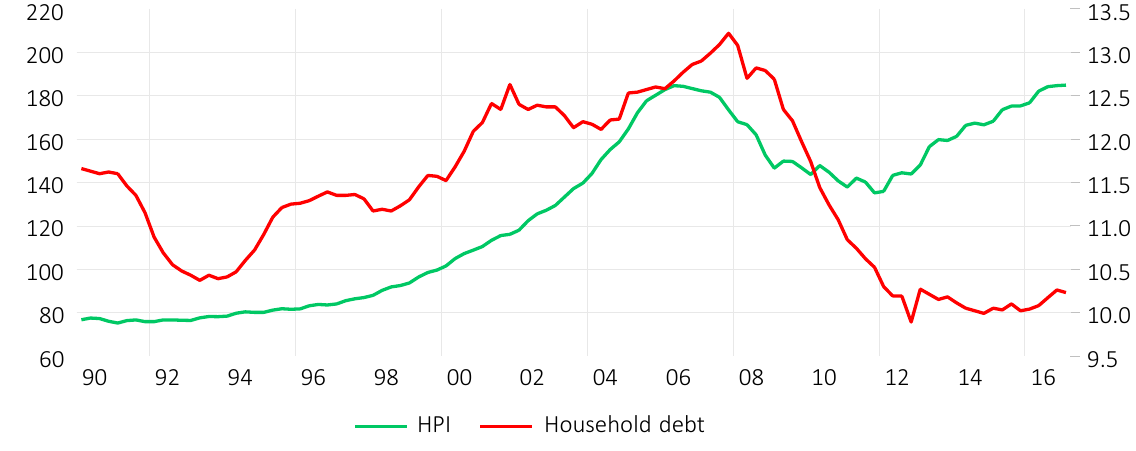
Figure 2. US housing price index vs US household debt